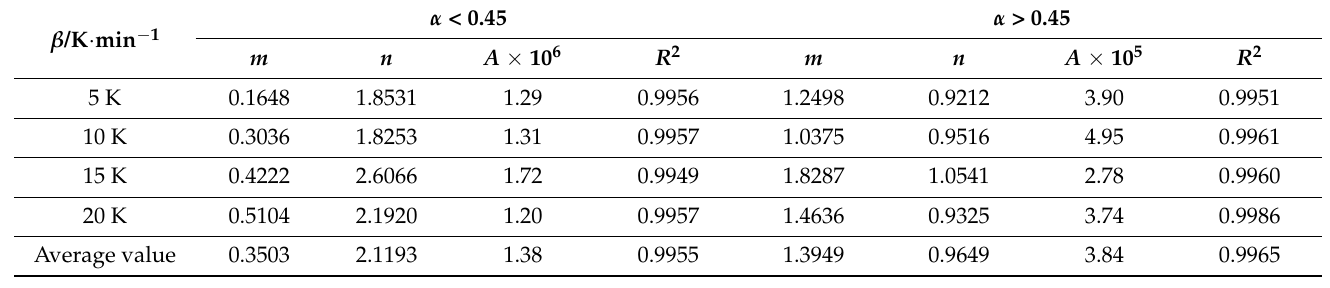
Table 2. Kinetic parameters of MDI-based polyurethane curing reactions calculated by Autocatalytic model.